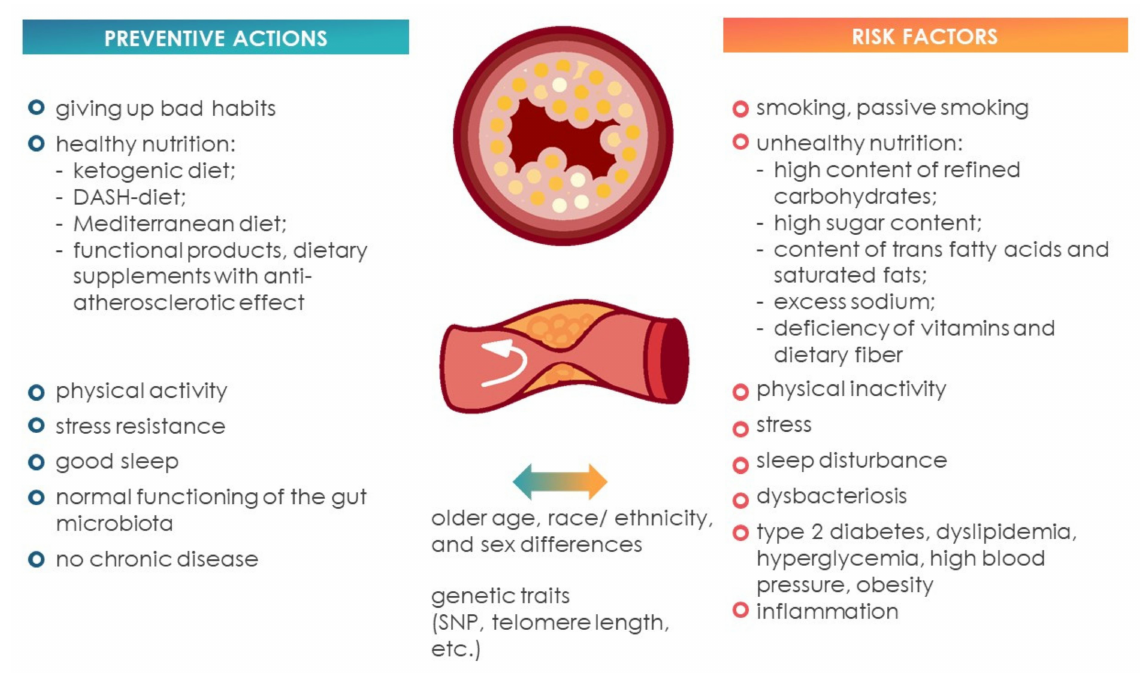
Figure 17. Factors influencing the development of